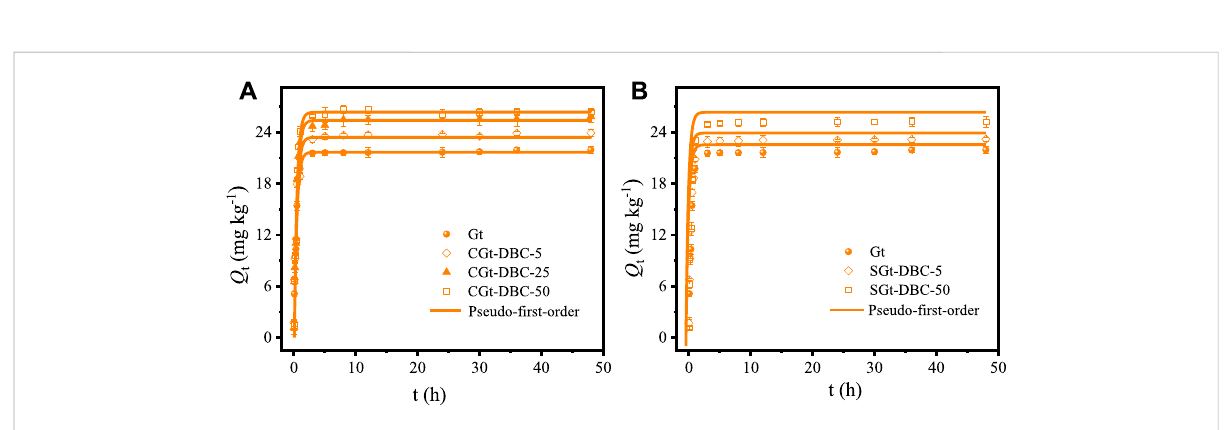
FIGURE 7 Adsorption kinetics of IMI on Gt and Gt-DBC samples and fi tting of pseudo- fi rst-order kinetics model [CGt-DBC, the coprecipitated Gt-DBC complexes; SGt-DBC, the adsorbed Gt-DBC complexes; Numbers indicate the additive concentration of DBC in the preparation of Gt-DBC samples; Q t is the adsorption concentration of IMI at time t